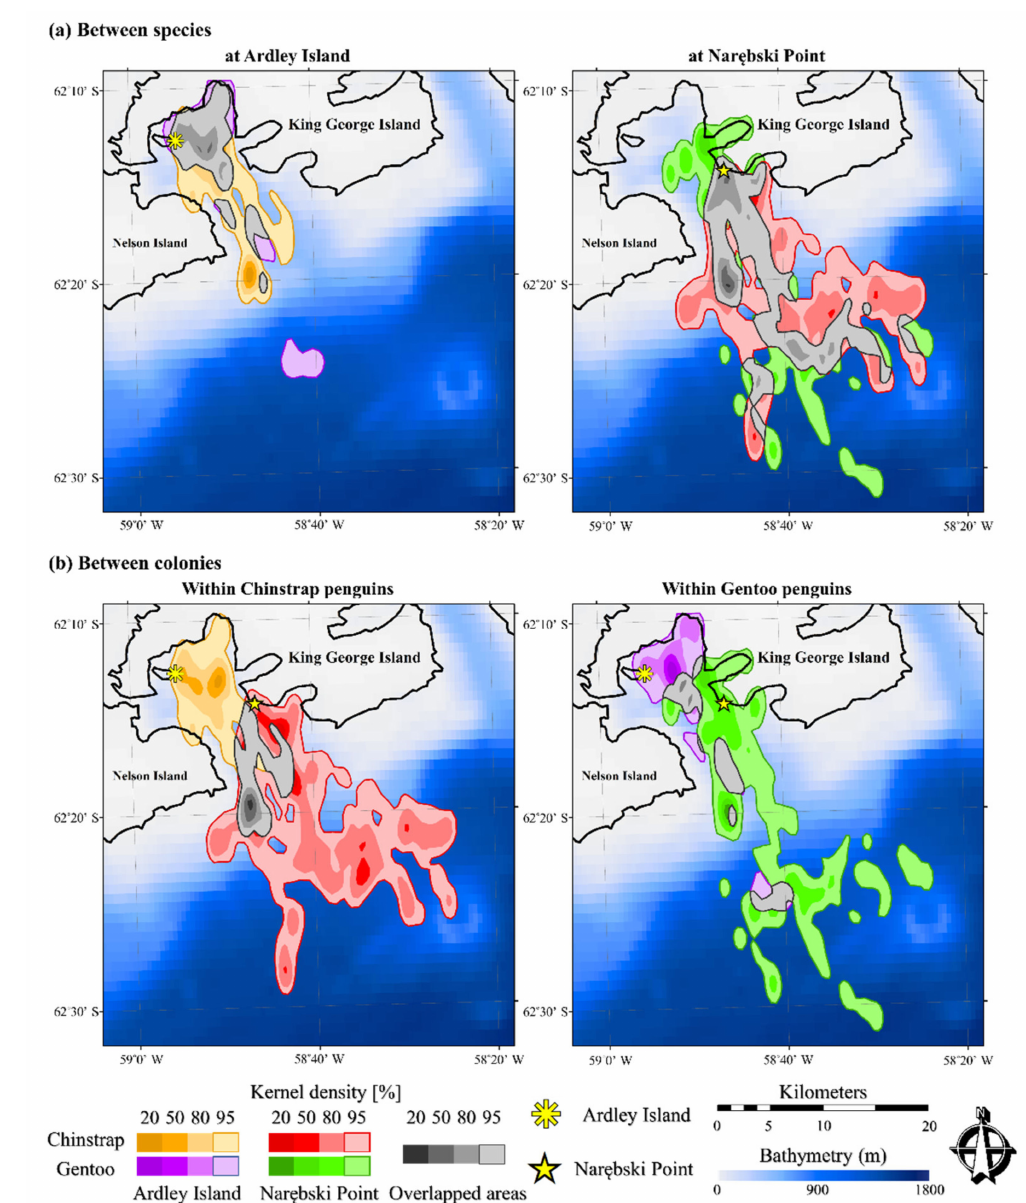
Figure 1. Foraging areas compared between species (Chinstrap vs. Gentoo penguins) ( a ) and between colonies (Ardley Island vs. Nar˛ebski Point) ( b ). An asterisk indicates the colony location at Ardley Island and a star indicates the colony at Nar˛ebski Point. The foraging areas and the overlapping areas are visualized by kernel density estimation (KDE) values, at 20%, 50%, 80%, and 95%. Trip parameters (trip duration, maximum distance, and movement distance)